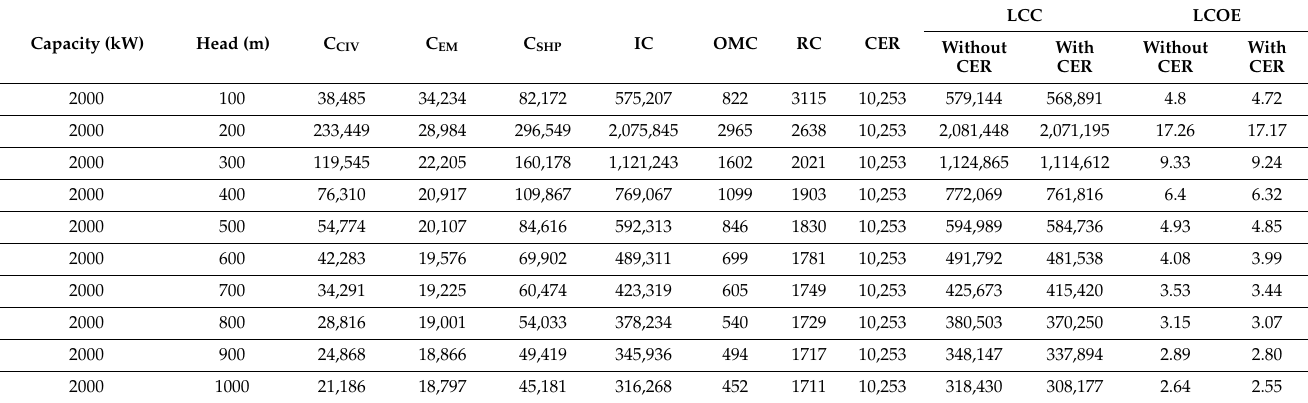
Table 6. LCOE values of high head SHP Plants with and without